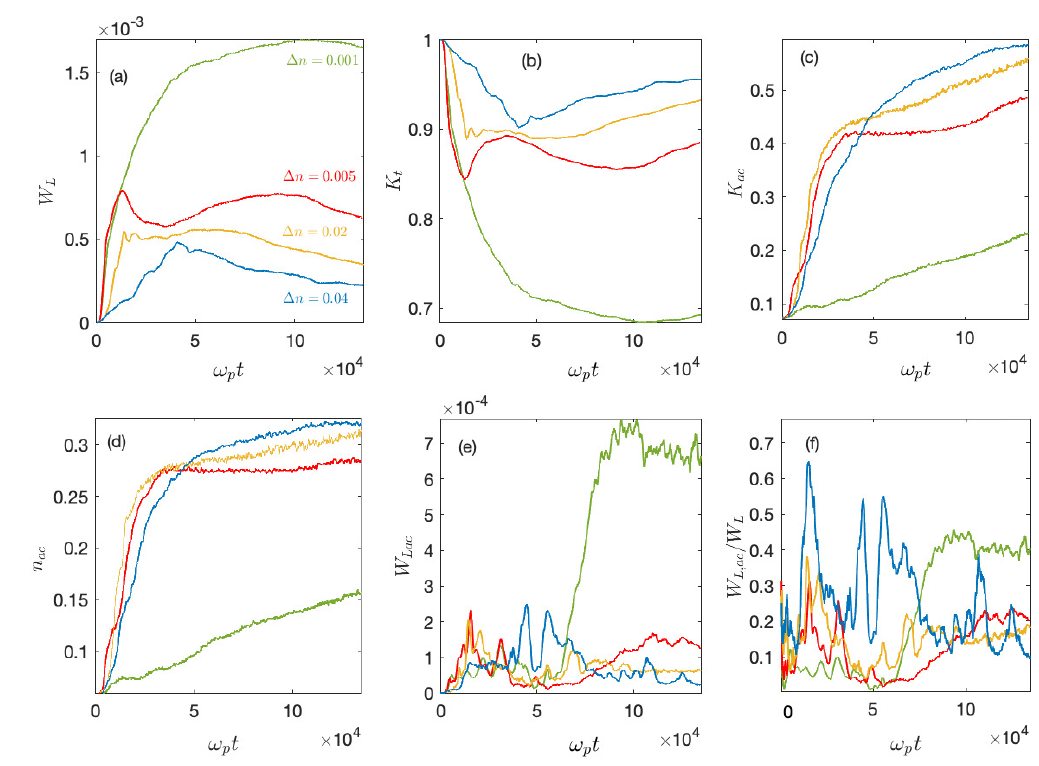
Figure 12. Time variations of different characteristics of the population of accelerated particles, for ∆ n = 0.001 (green), 0.005 (red), 0.02 (yellow), and 0.04 (blue). ( a ): Langmuir wave energy density W a function of time. ( b ): Beam kinetic energy K t as a function of time. ( c ): Kinetic energy K ac carried by the accelerated electrons, as a function of time. ( d ): Density n ac of the accelerated electrons, as a function of time. ( e ): Fraction W L , ac of the energy density W L carried by the Langmuir waves with phase velocity v ϕ > v ac , as a function of time. ( f ): Ratio W L , ac / W L as a function of time. Main parameters are the following: v b / v T = 14, n b / n 0 = 5 × 10 − 5 . All variables are normalized (see the